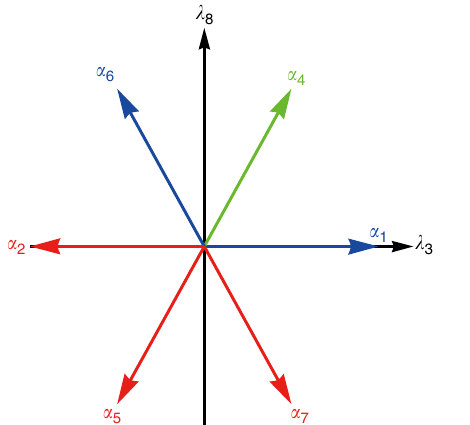
Fig. 2 The root system R of su 3 ð Þ . It consists of six non-zero root vectors on the λ 3 − λ 8 plane. Among them, α 1 (blue), α 4 (green), and α 6 (blue) are positive and the other three (red) are negative since roots are always come in pair with opposite directions. Also, α 1 and α 6 are simple because α 4 = α + α 1 6 is a combination of simple (cid:4) (cid:5) e e e = 2, which is diagonal in the þ λ L L representation H λ ¼ λ 3 3 8 8 gl 3 ð Þ basis.